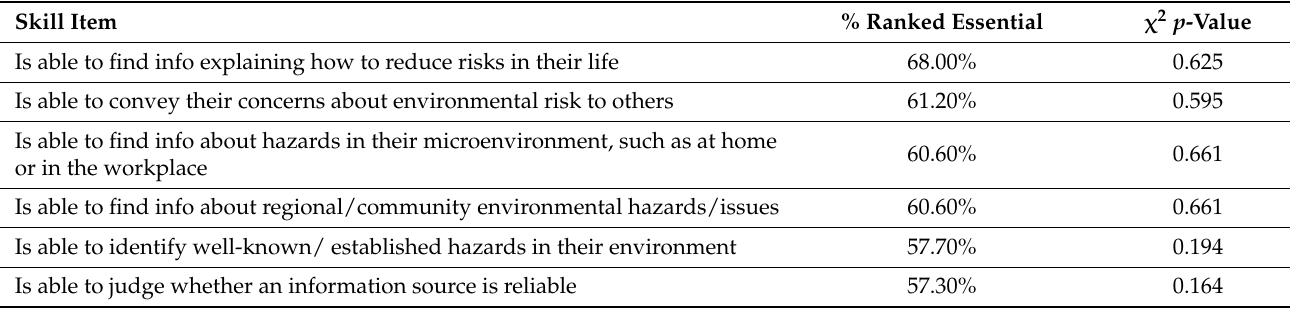
Table 2. Highest cluster of essential skill items.